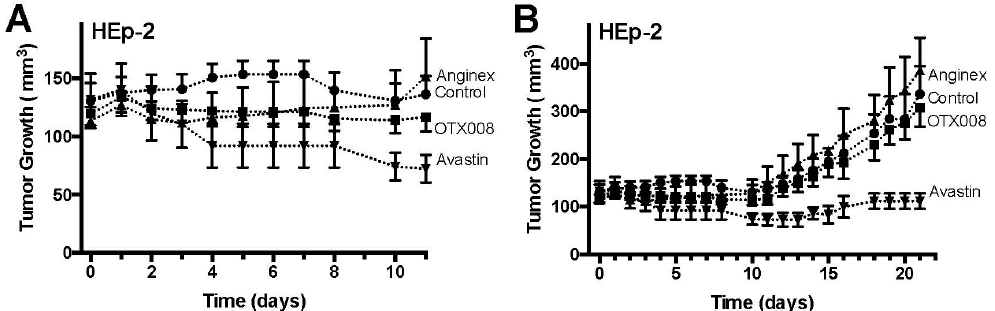
Figure 3. OTX008 inhibits HEp-2 tumor growth in mice. ( A ) HEp-2 tumor growth during the first 11 days and treatment with Control (vehicle), Anginex, OTX008 and Avastin; ( B ) HEp-2 tumor growth during the whole treatment span with Control (vehicle), Anginex, OTX008 and Avastin. Treatments: Control (vehicle; - -), Anginex (i.p. 10 mg/kg, q1d×21; n = 7; - -), OTX008 (i.p. 10 mg/kg, q1d×21; n = 7; - -), and Avastin (i.v. 10 mg/kg, q14d×2; n = 7; - -). Data points represent means ± SEM ( n = 7 each group).